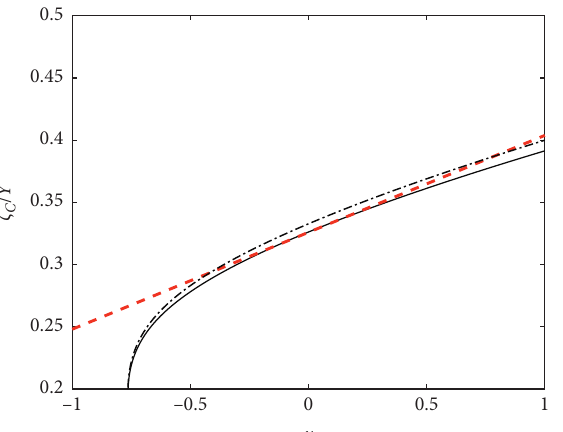
􏽢 Y ) to attain the lowest resonance frequency, as a function of c , for 􏽢 Y � 0 . 1 (thin solid line) and 􏽢 Y � 0 . 5 (thin dash- Figure 12: Ratio ( ζ C / dotted line), and approximate expression in equation (20) represented as thick dashed